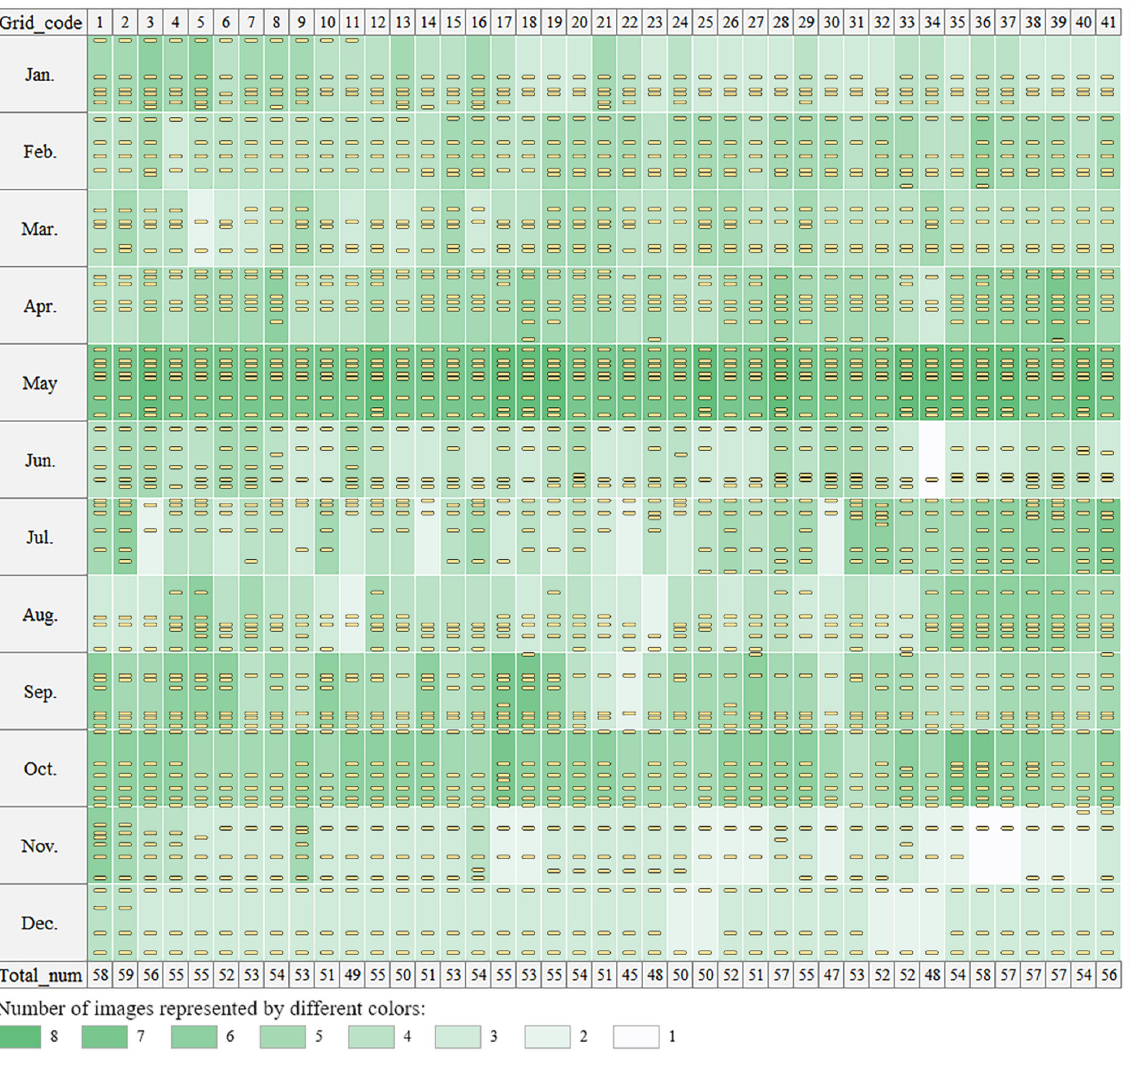
Figure 4. Irregular time series data information. Different colors represent the number of images in different months, and dots indicate that there are images selected in this period.